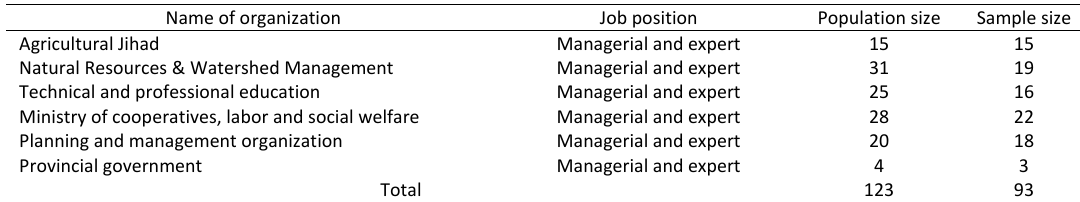
Table 1: the studied population and sample size